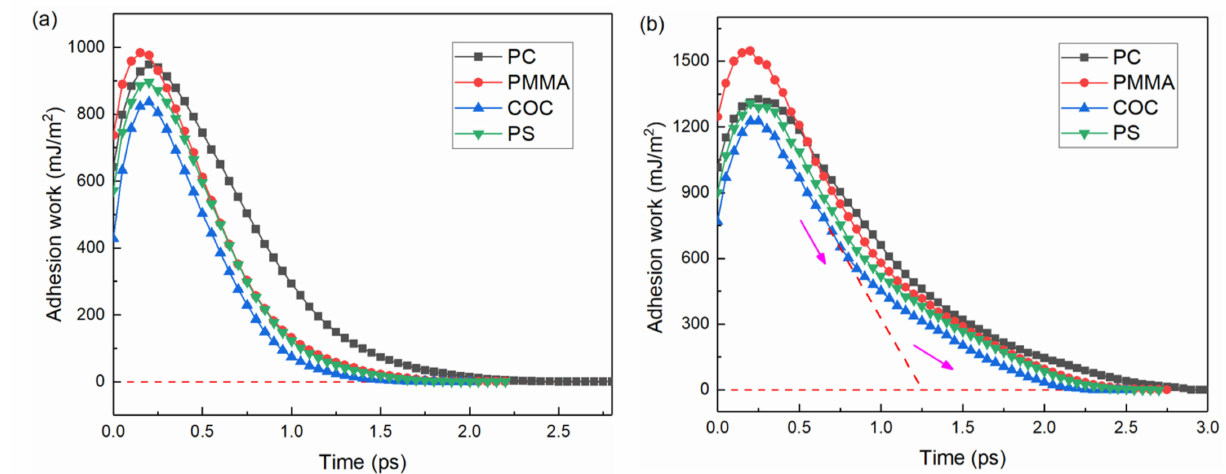
Figure 9. The adhesion work of PC, PMMA, COC and PS in demolding: ( a ) channel structures, ( b ) mixing